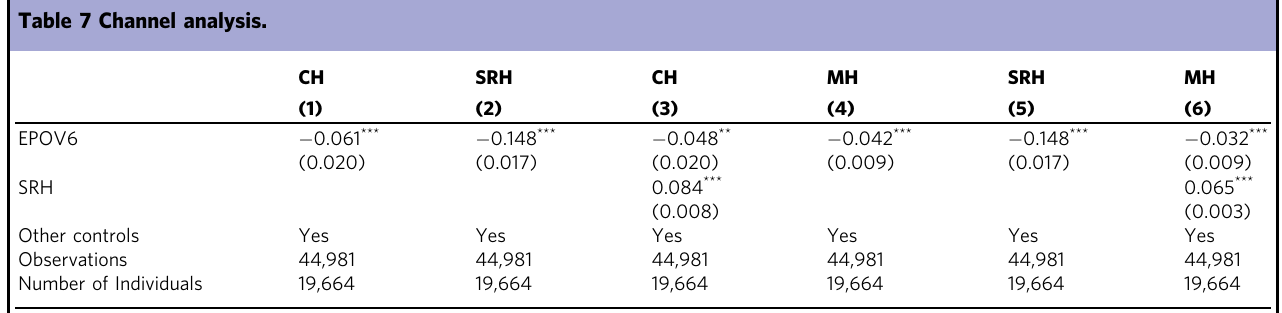
Table 7 Channel